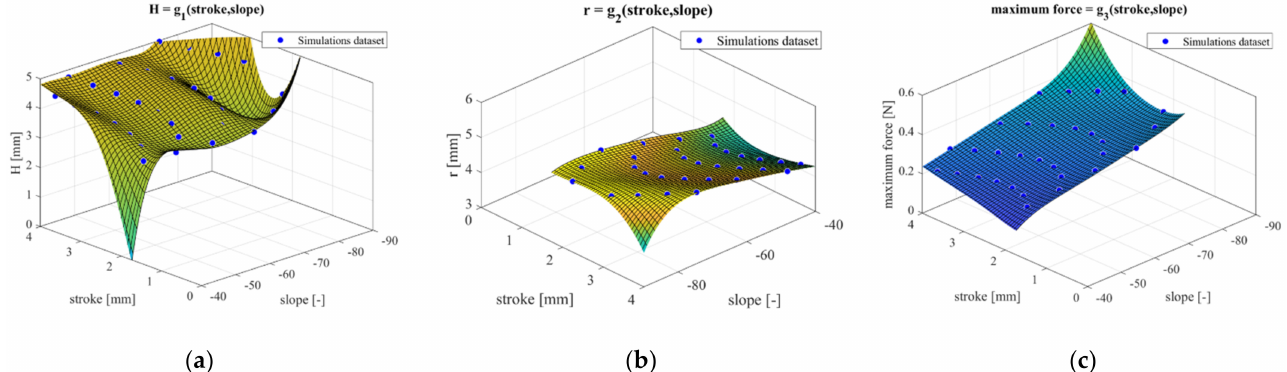
Figure 15. Surface fitting functions created based on the simulations dataset, with the final goal of deriving the dome geometric values for H and r based on the desired performance: ( a ) H as a function of stroke and slope; ( b ) r as a function of stroke and slope; ( c ) maximum force as a function of stroke and